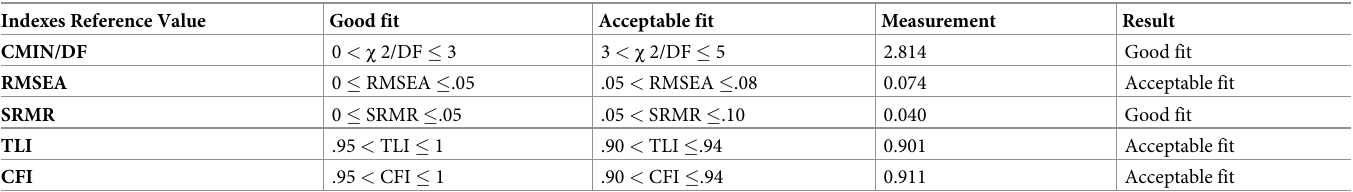
Table 3. Predicted goodness of fit reference values for Confirmatory Factor Analysis (CFA) and